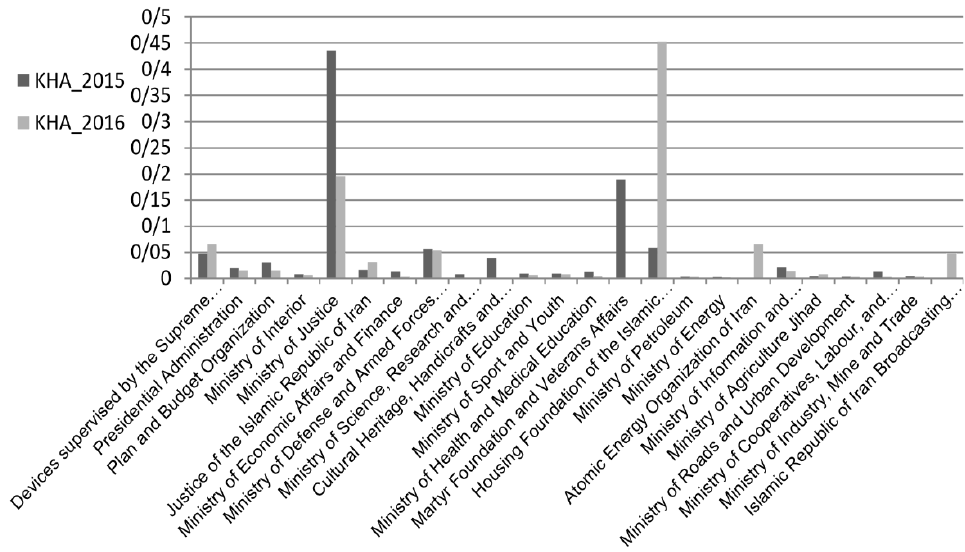
Fig. 2. A comparison of the performance of the executive agencies in 2015-2016 utilizing the KHA